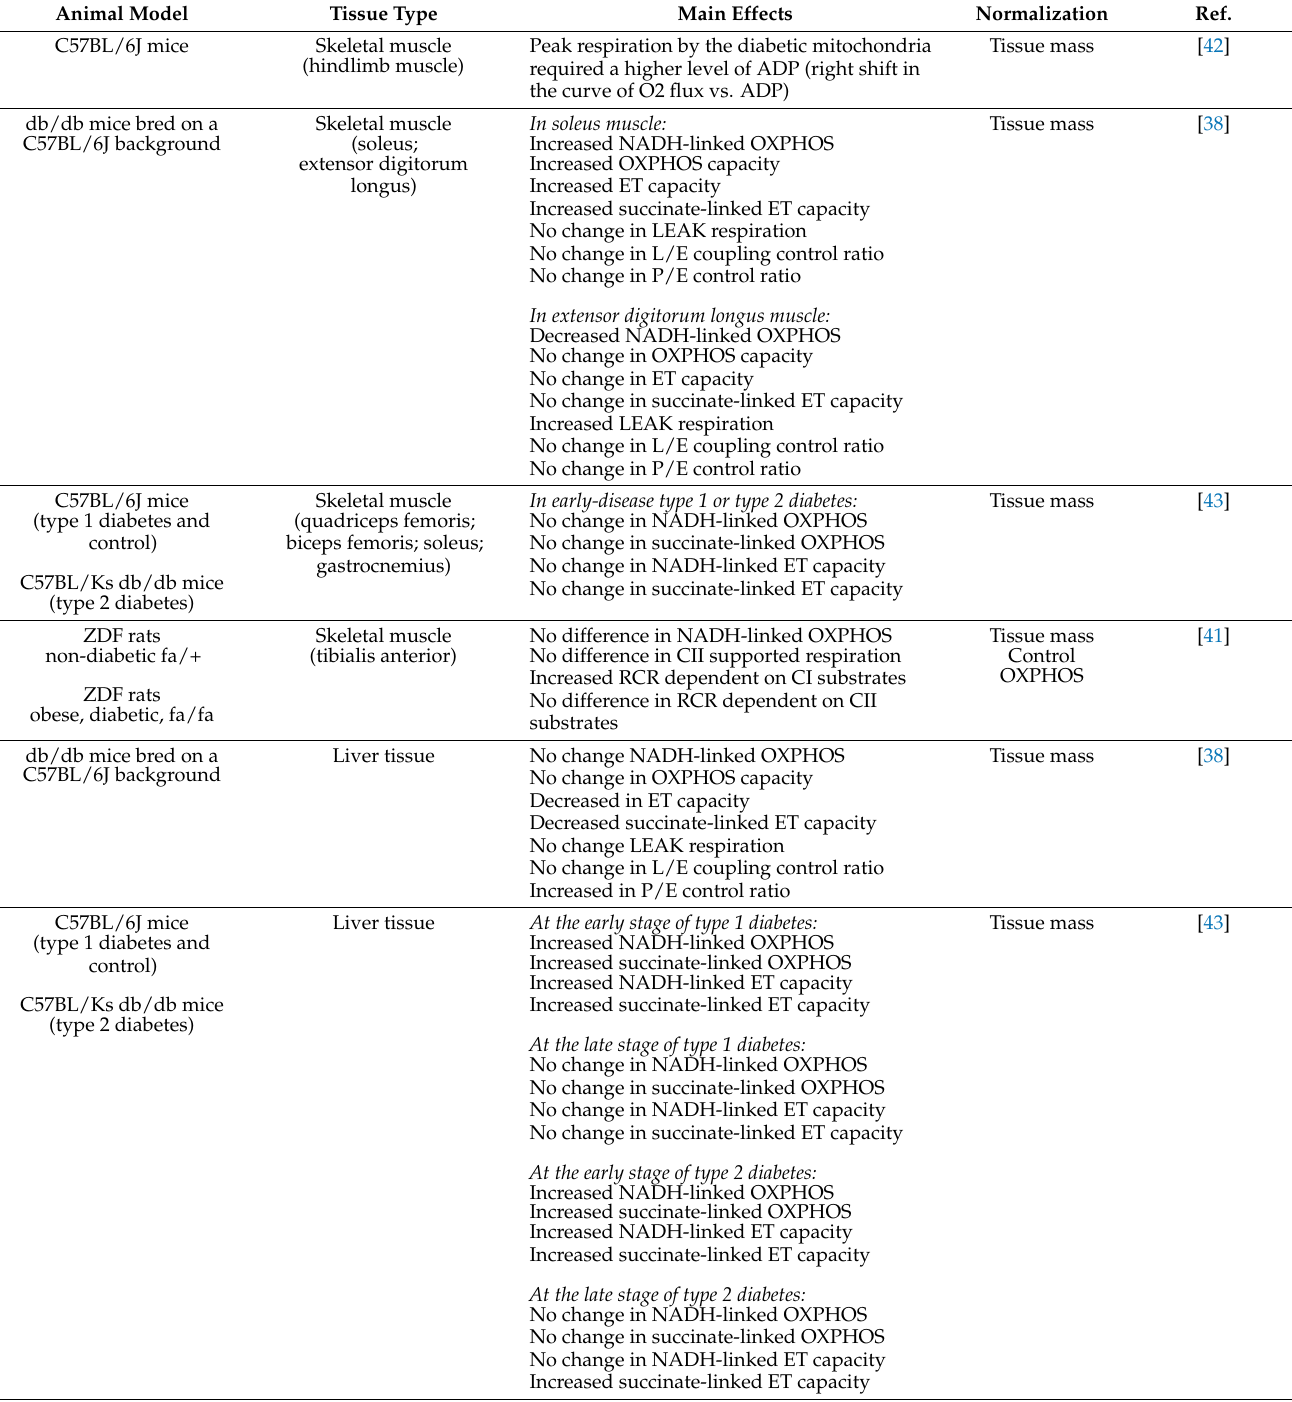
Table 3. High-resolution respirometry findings in animal diabetes